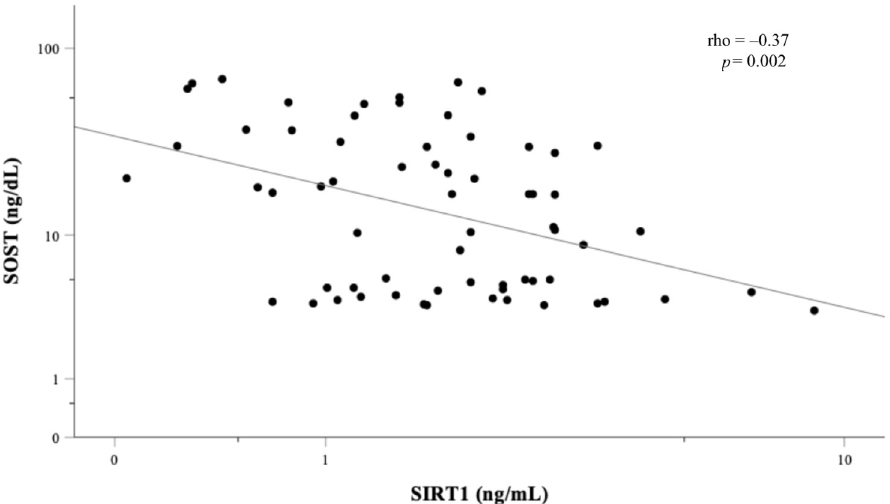
Figure 1. Bivariate correlation between circulating SIRT1 and sclerostin (SOST). Data were log-transformed. Correlation coefficient ( ρ ) and level of significance ( p ) are provided.